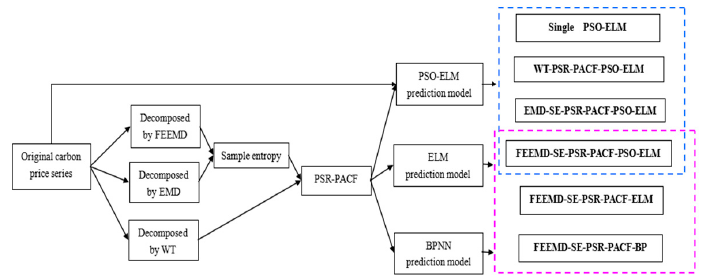
Figure 10. The framework of the forecasting models under comparison. BPNN, back propagation neural network.